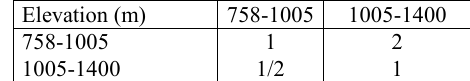
Table 1. Example of a pair wise comparison